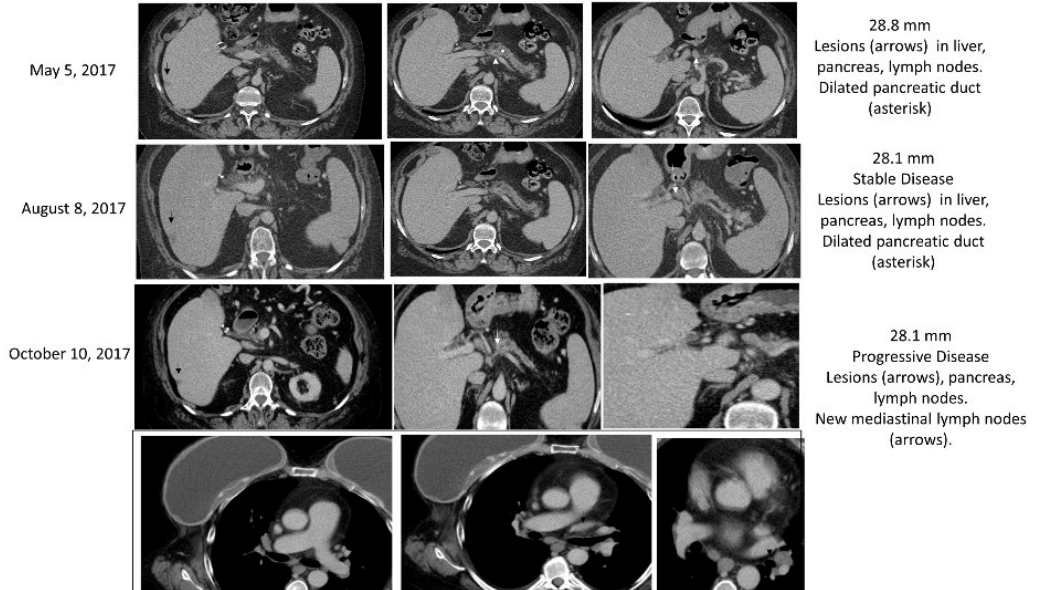
Figure 5. Case 4 treatment responses. Legend: Treatment with MMC resulted in stable disease, in multiple liver secondary lesions (arrows). Later, disease progression was observed with new mediastinal lymph nodes (images below).